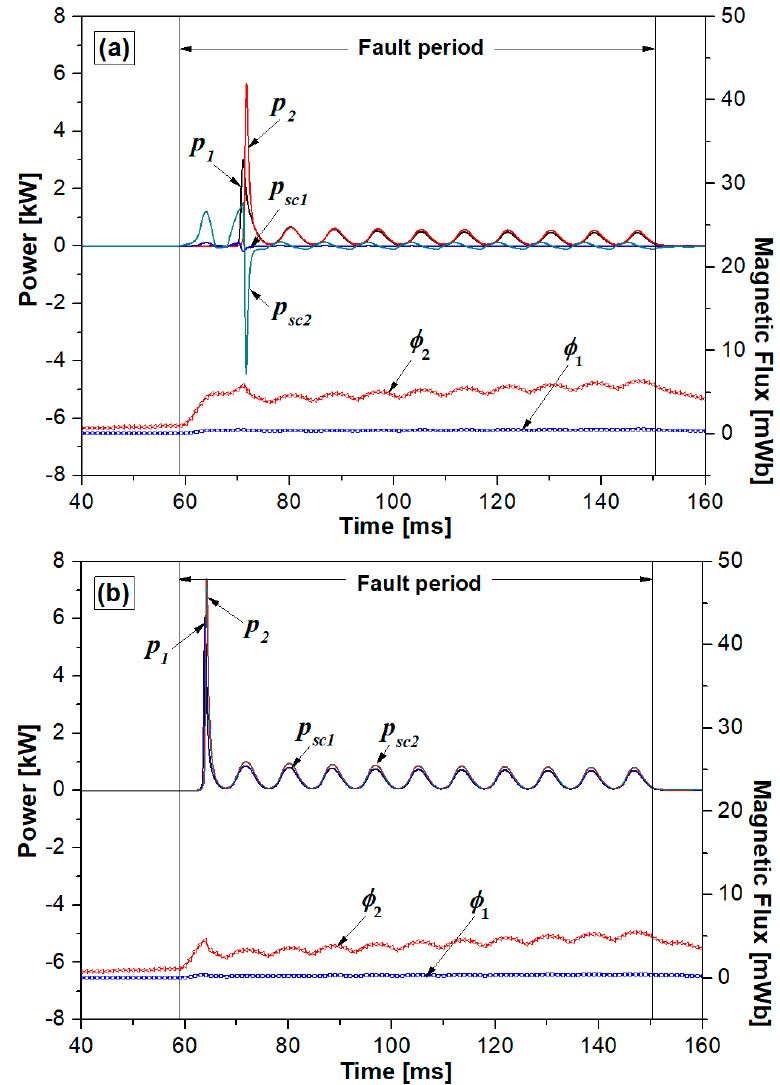
Figure 6. Instantaneous powers and magnetic flux in each winding of bridge type SFCL using flux-coupling according to the change of input voltage source. ( a ) E in = 80 V rms . ( b ) E in = 100 V rms .